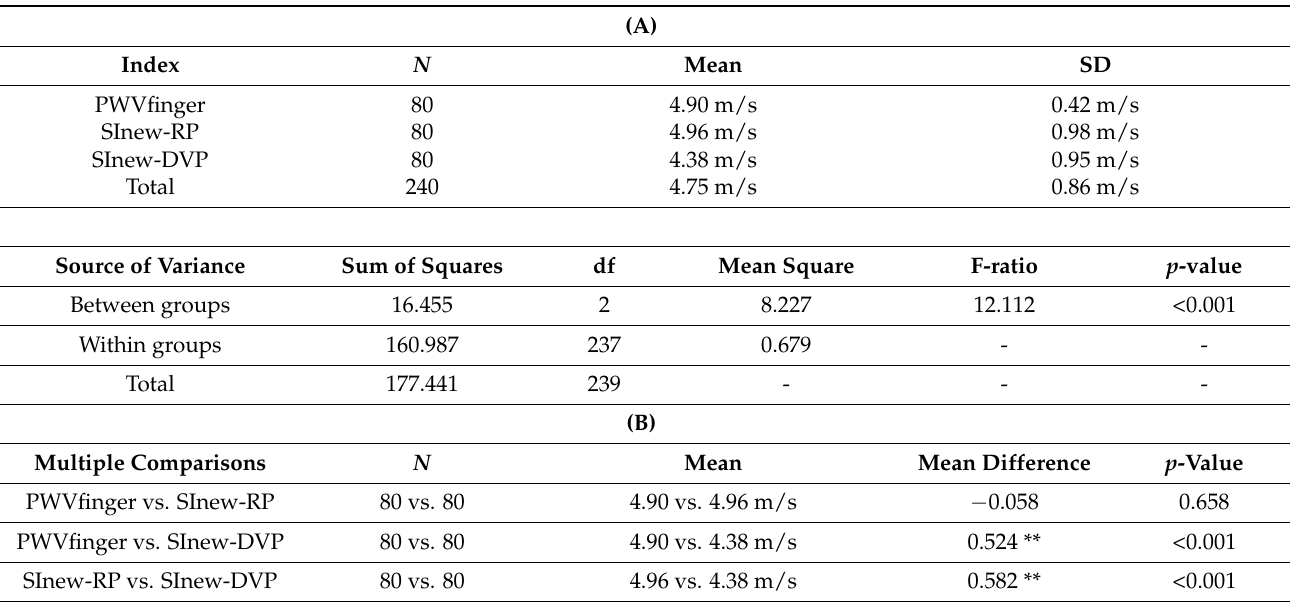
Table 3. ( A ). One-way analysis of variance for the three indices (PWV finger , SI new -RP, and SI new -DVP) applied to Group 1 (healthy middle-aged subjects) and Group 2 (type 2 diabetic subjects). ( B ). Fisher’s LSD post hoc test for the three indices (PWV finger , SI new -RP, and SI new -DVP) applied to Group 1 (healthy middle-aged subjects) and Group 2 (type 2 diabetic subjects).